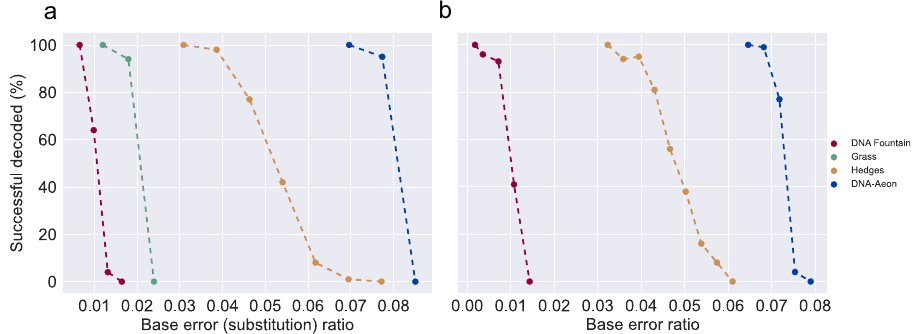
Fig. 1 | Base error ratio comparison: percentage of successful decoding attempts for a given base error (substitution) ratio (a) and percentage of successful decoding attempts for a given base error ratio (b), using the pro- portions of substitutions, deletions and insertions described in 12 (high muta- genesis),withamultiplierbetween0.1and2.2. Theoutputconstraintsusedwere a maximum homopolymer length of 3 and, for the codes that support it, a GC